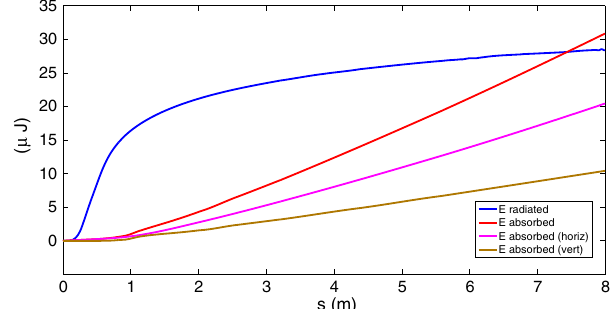
FIG. 15. The total energy radiated in perfectly conducting model (blue); energy absorbed in perturbative model (red); energy absorbed in horizontal walls, perturbative model (ma- genta); energy absorbed in vertical walls, perturbative model (brown). The beginning of the bend is at s ¼ 0 , where the fields have the steady-state values for an infinite straight